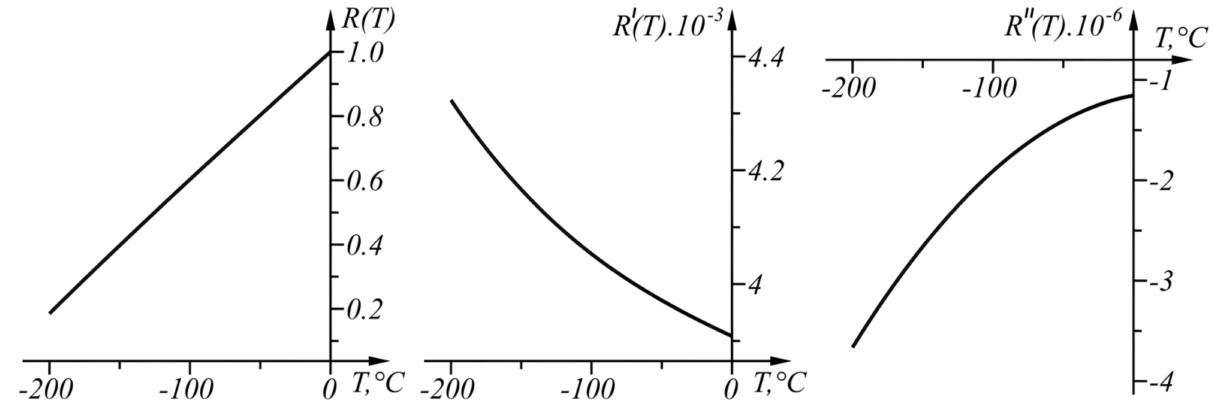
Figure 9. Graphs of the functions R ( T ), R (cid:48) ( T ) , and R (cid:48)(cid:48) ( T ) in the range T ∈ [ − 200,0 ] ◦